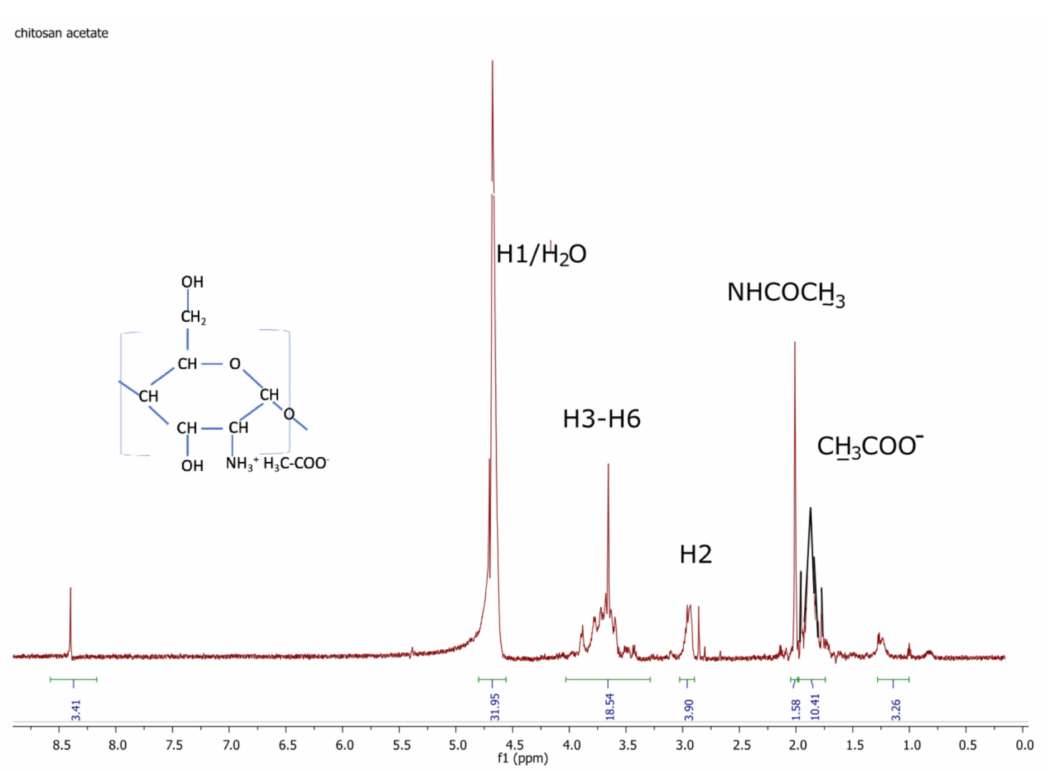
Figure 6. 1 H-NMR spectrum of chitosan